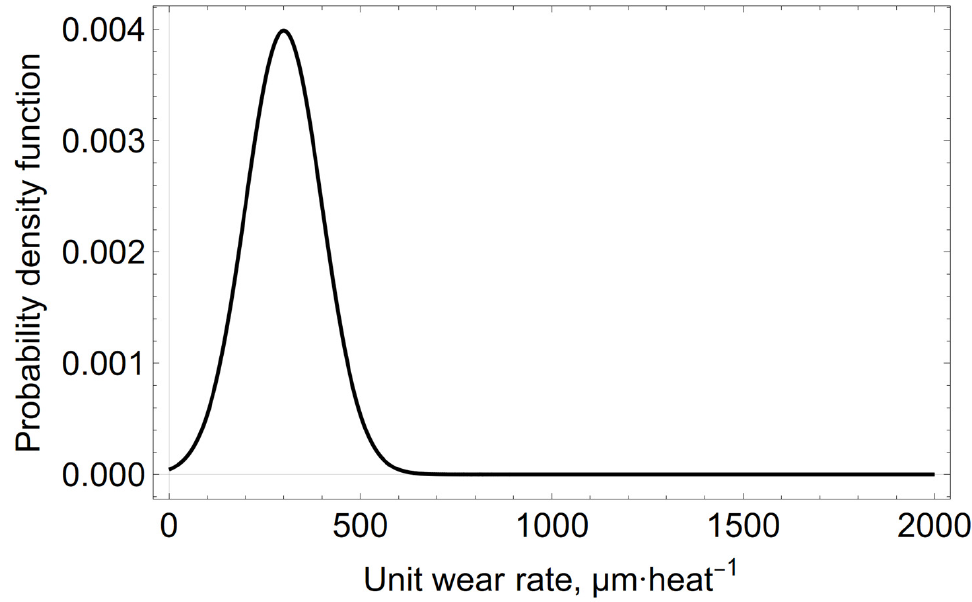
Figure 4. A priori normal distribution, expressing the initial belief in the distribution of the unit wear rate with parameters µ 0 = 300 µm heat − 1 , σ 0 = 100 µm heat − 1 . The mean value of the a posteriori normal distribution for the conjugate solution, assum- ing the normality of the a priori distribution, is calculated according to Formulas (1) and (4). The precision, which is the inverse of the variance σ 2 , is expressed by Formula (5). For a known standard deviation σ = 50 µ m heat − 1 and with the hyperparameters of the a priori distribution being µ 0 = 300 µ m heat − 1 and σ 0 = 100 µ m heat − 1 , the values of µ aposteriori and τ aposteriori calculated from Formulas (4) and (5) for successive measurements are shown in Figures 5 and 6.